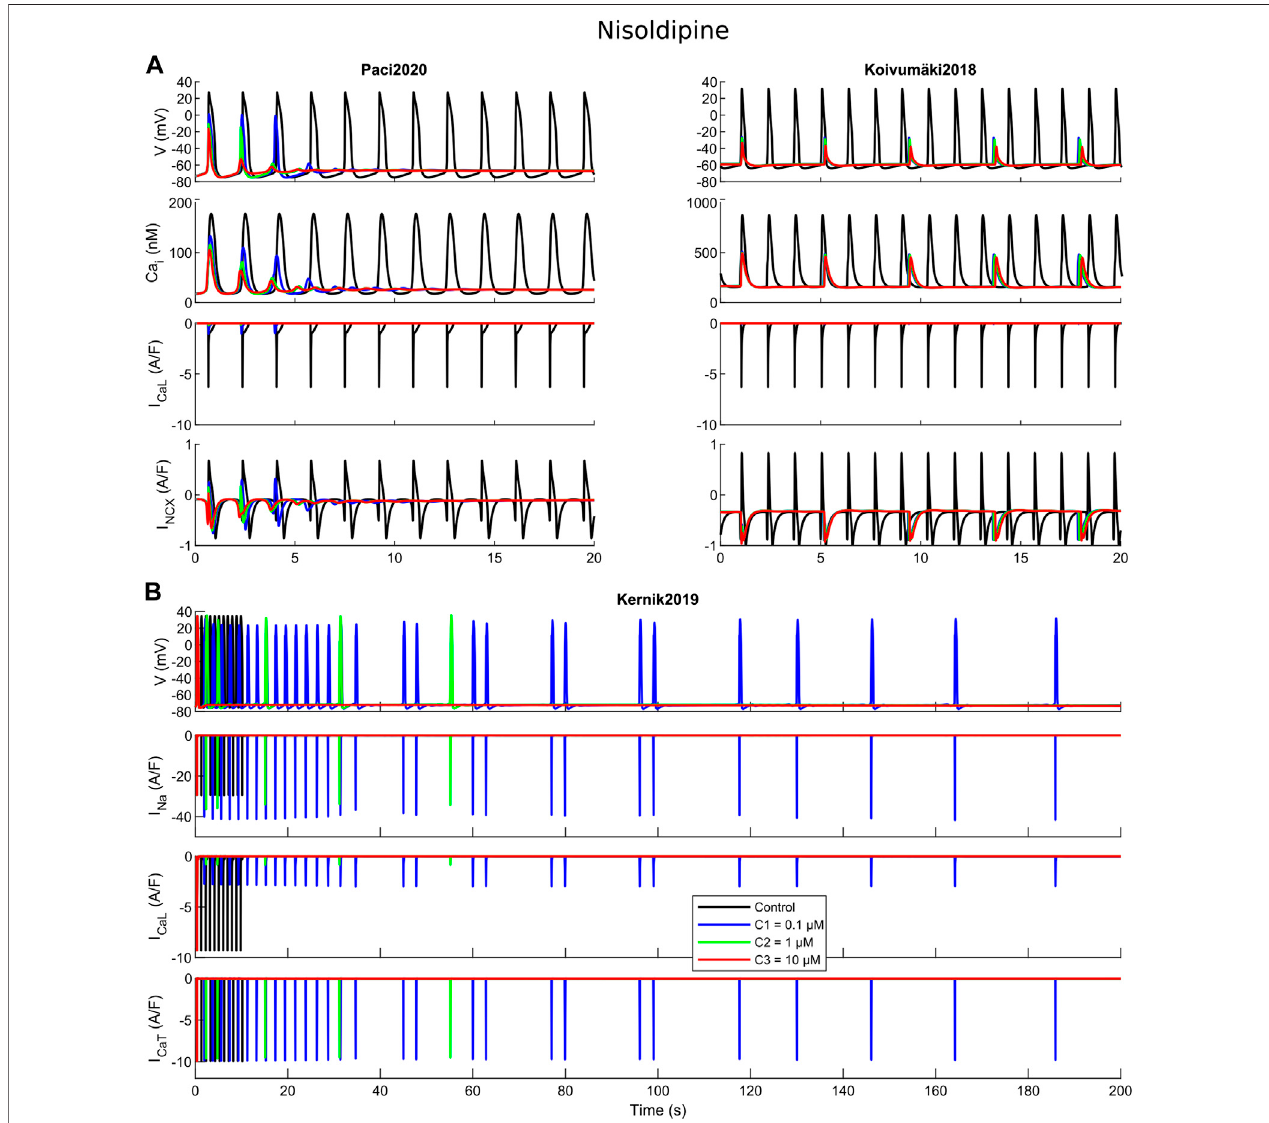
FIGURE 5 | Cessation of the spontaneous electrical activity upon administration of nisoldipine. For all the three tested concentrations (C1, C2 and C3), Paci2020 becomes quiescent and Koivumäki2018 maintains a residual electrical activity not suf fi cient to trigger action potentials. For concentrations one and two, Kernik2019 shows an irregular rhythm before quiescence, while concentration three terminates immediately the